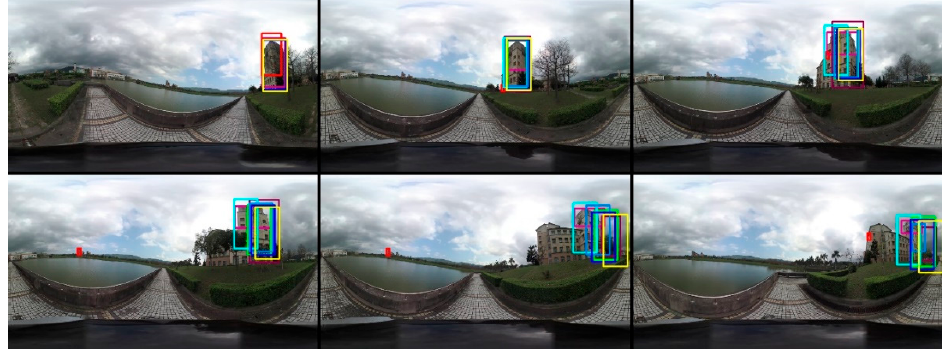
Figure 10. Tracking results on 360-degree video sequence 7 (tracking windows with different colors: MOSSE MIL MedianFlow BOOST TLD KCF GOTURN CSRT).